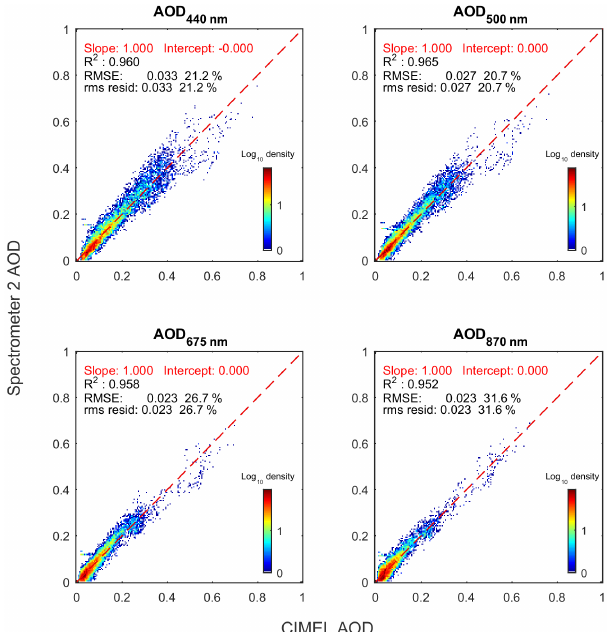
Figure 9. Corrected Zeiss AOD values compared with CIMEL sun photometer at